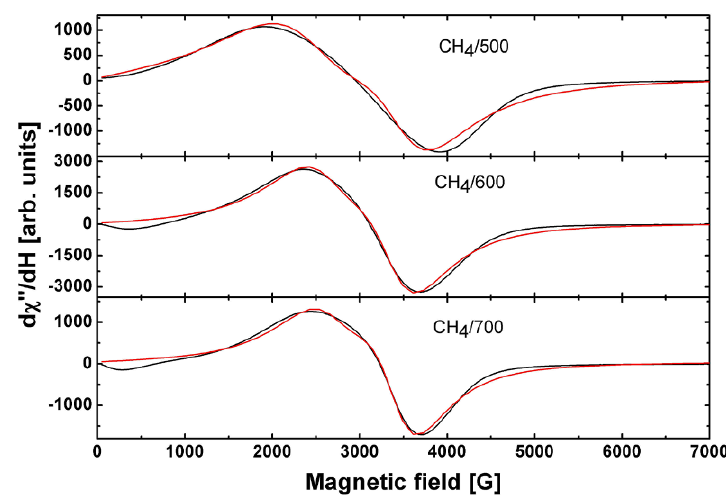
Figure 3. Experimental (black) and fitted (red) spectra of three samples carburized in methane.